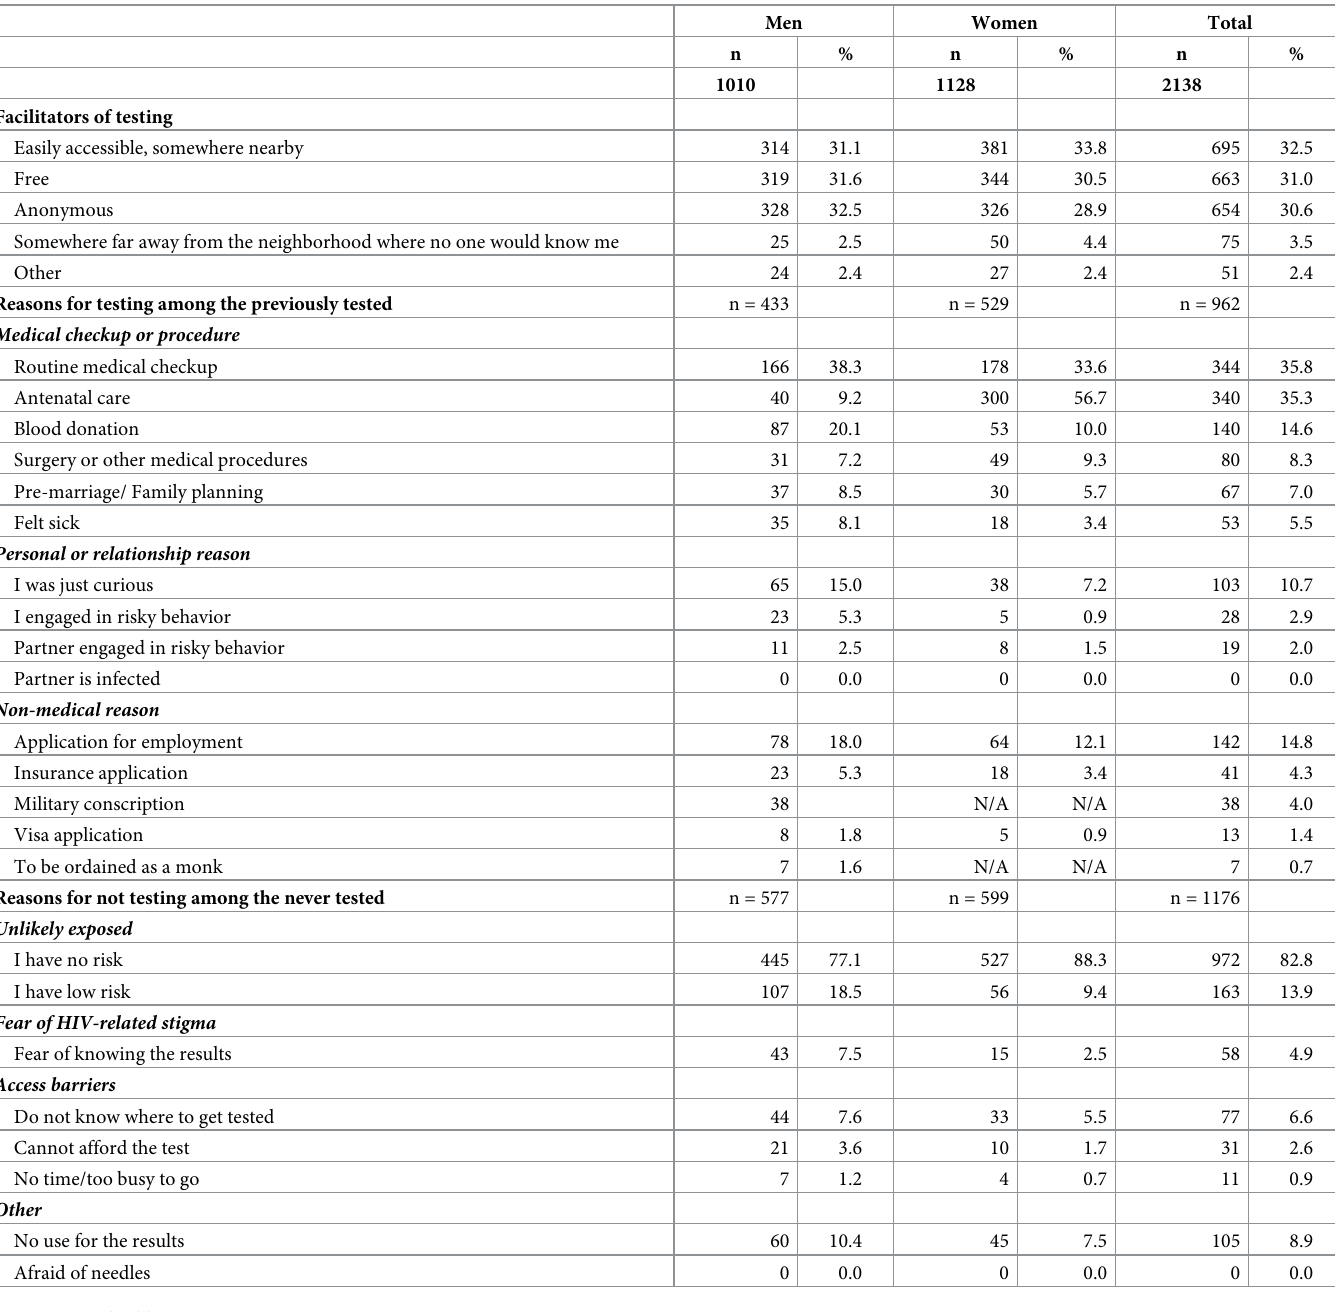
Table 3. Facilitators of HIV testing, reasons for testing, and reasons for not testing by gender.